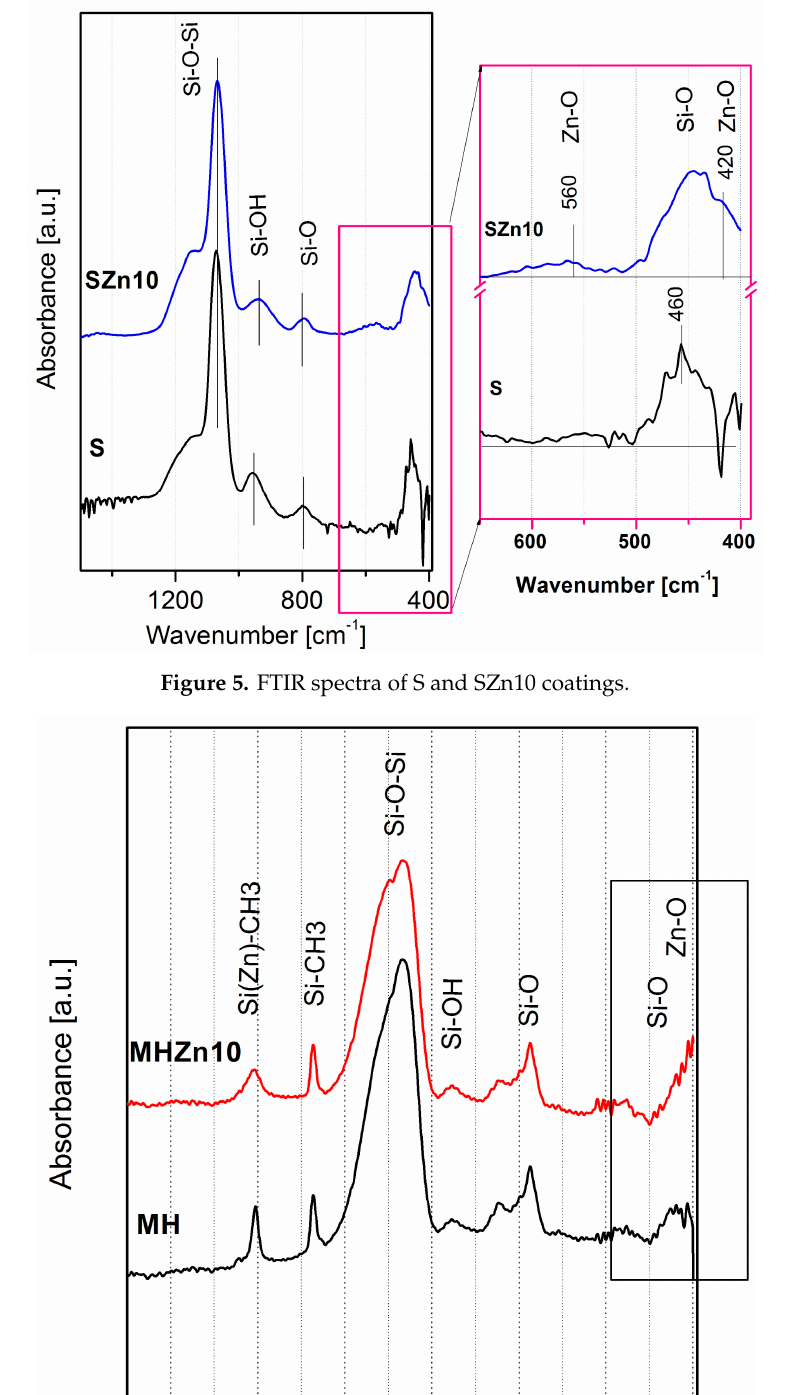
Figure 4. FTIR spectra of coatings obtained from sols S, M and MH.